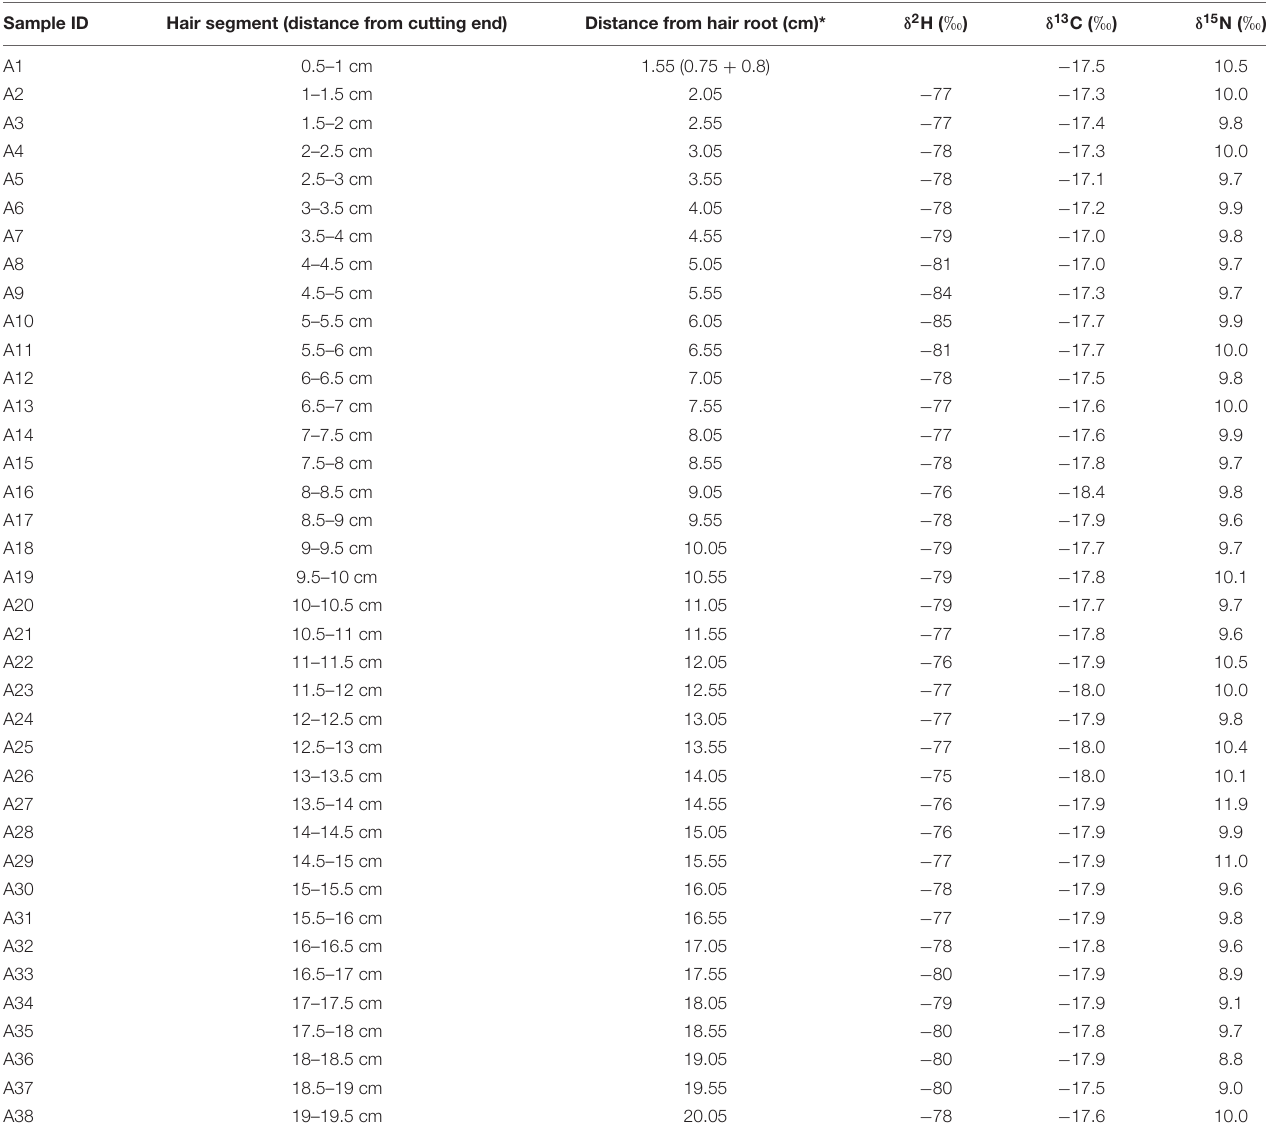
TABLE 2 | Stable isotope values of hair segments. Sample